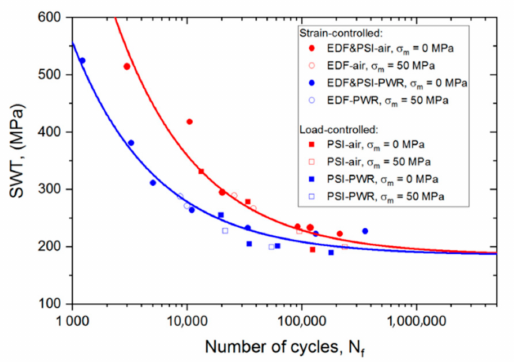
Figure 8. Smith–Watson–Topper (SWT)–life curve calculated with the specific 304L mean curve